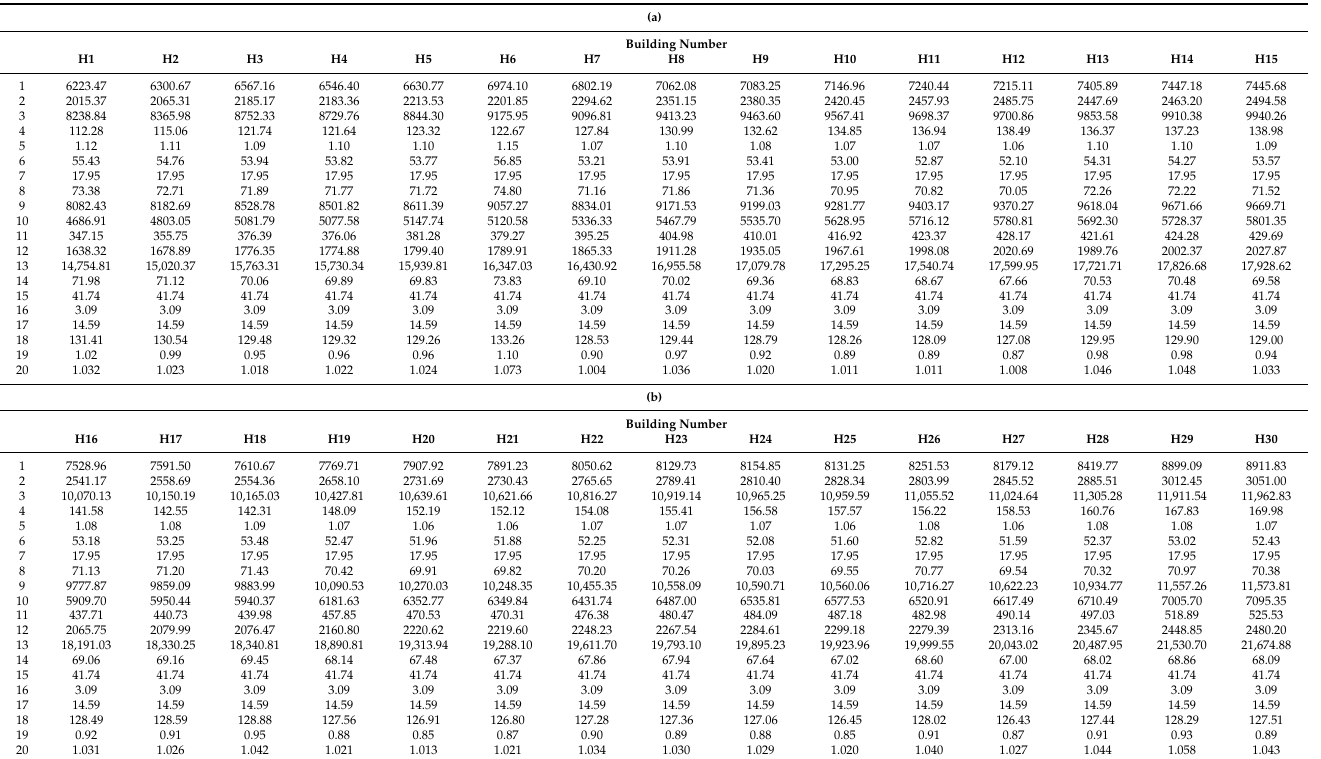
Table 5. Usable and final energy demand for buildings H1–H15. End use (kWh/year): (1)